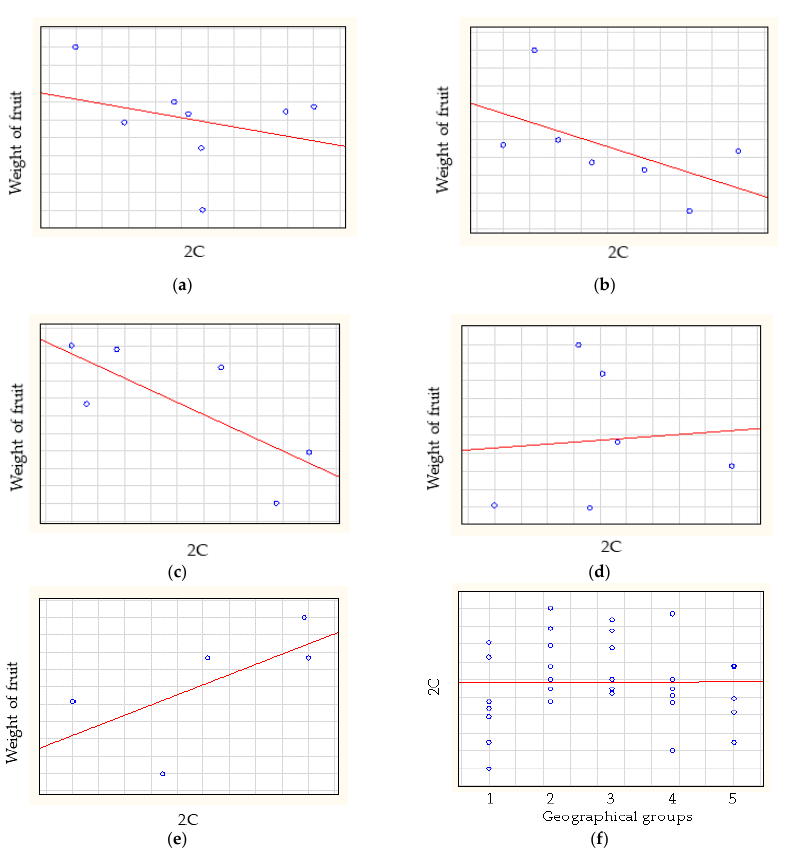
Figure 5 . The correlations between relative genome size and the weight of fruit of ( a ) American, ( b ) European, ( c ) Turkish, ( d ) Central Asian and ( e ) East Asian apricot cultivars. ( f ) The correlation between relative genome size and the geographical origin of apricot cultivars.